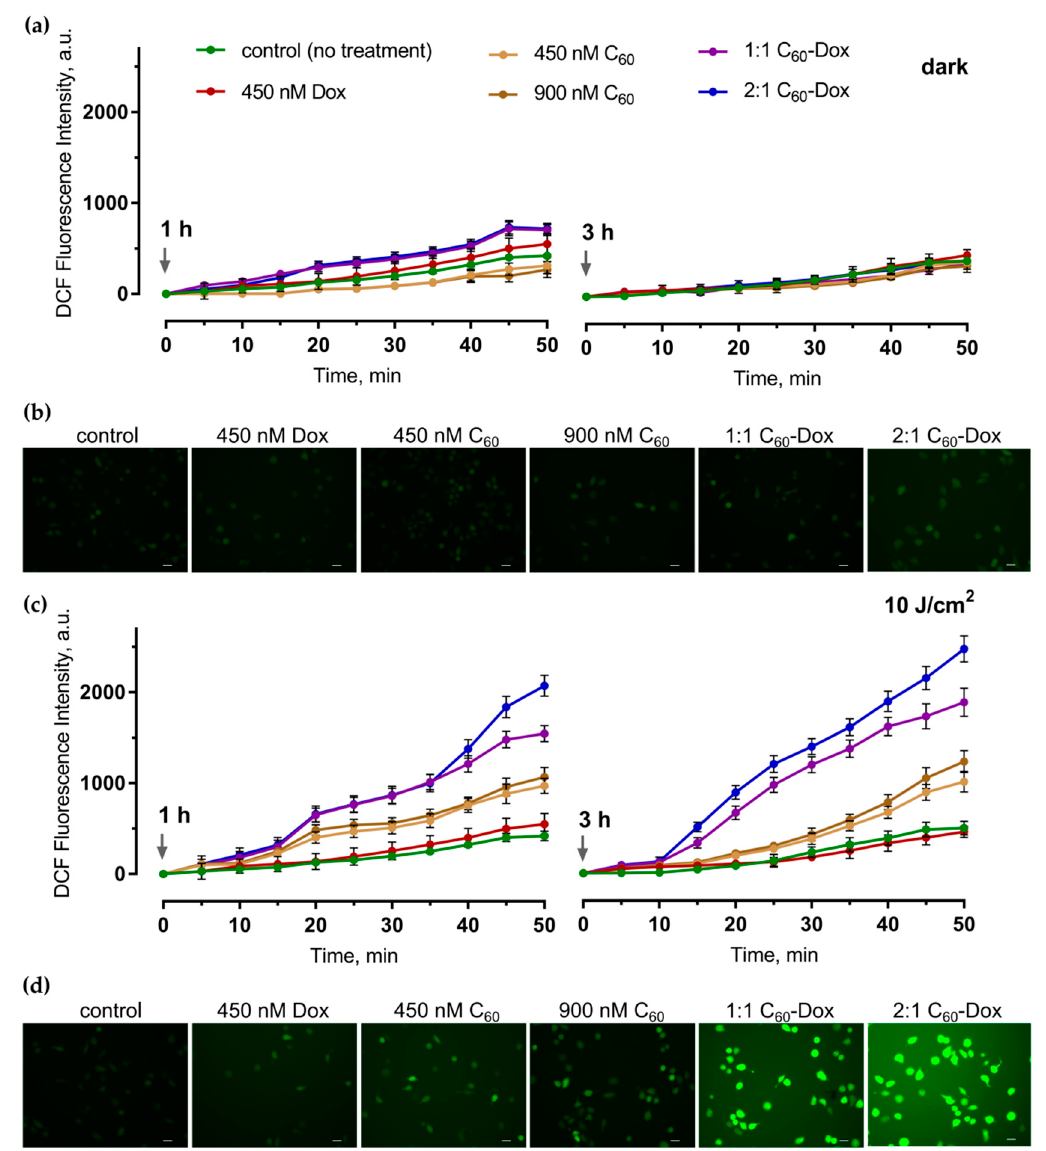
Figure 6. Reacrive oxygen species generation in CCRF-CEM cells treated with either Dox or C 60 alone or with C 60 -Dox nanocomplexes: the dynamics of ROS generation in cells at 1 and 3 h after the treatment in the dark ( a ) or irradiation with 10 J/cm 2 405 nm LED ( c ); the fluorescence microscopy images of cells at 3 h after the treatment in dark ( b ) or light irradiation ( d ) and further 60 min incubation with 2,7-dichlorofluorescin diacetate (DCFH-DA); scale bar corresponds to 20 µm.